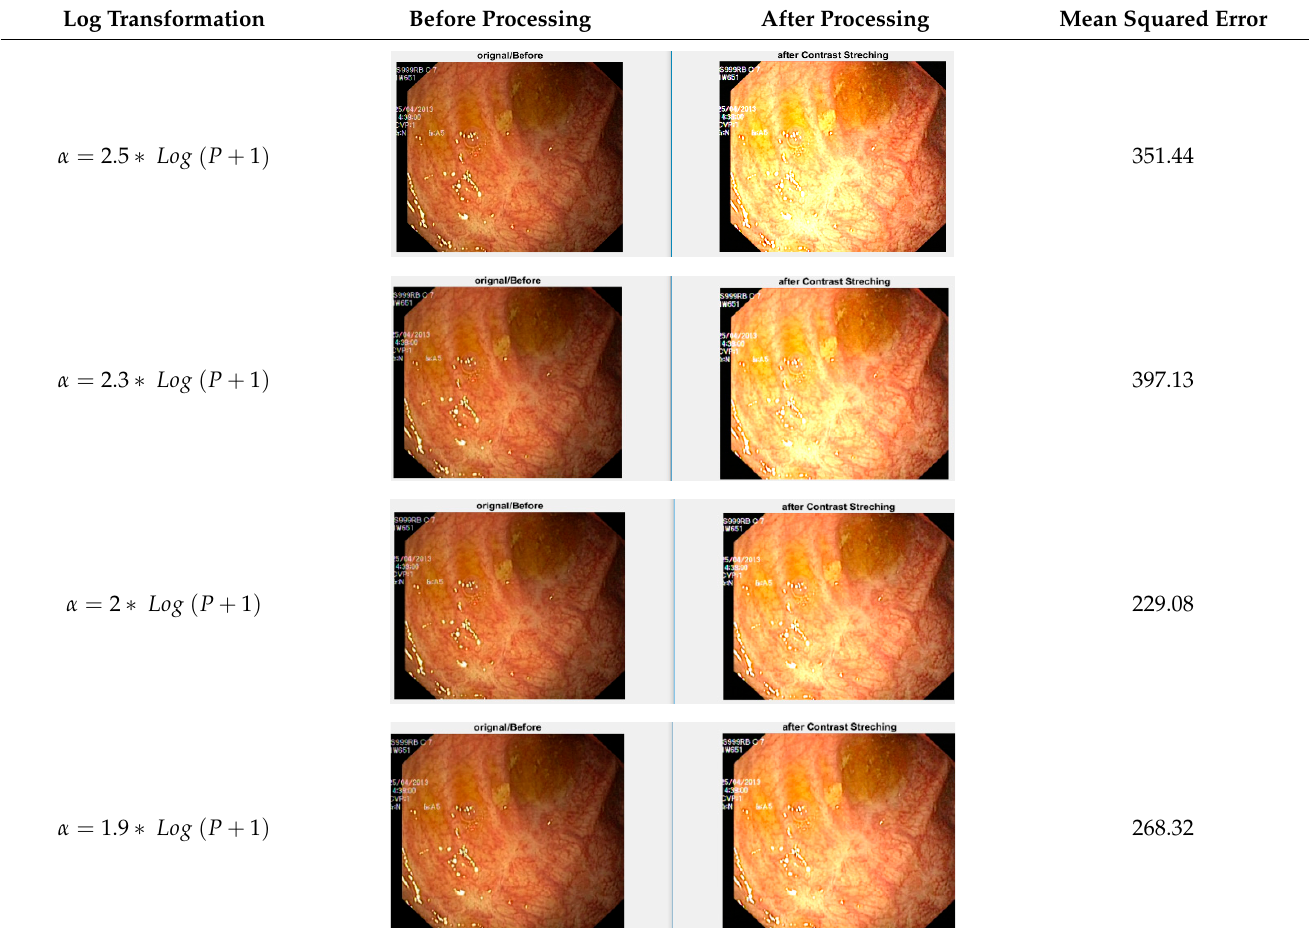
Table 2. Results after applying Log Transformation.